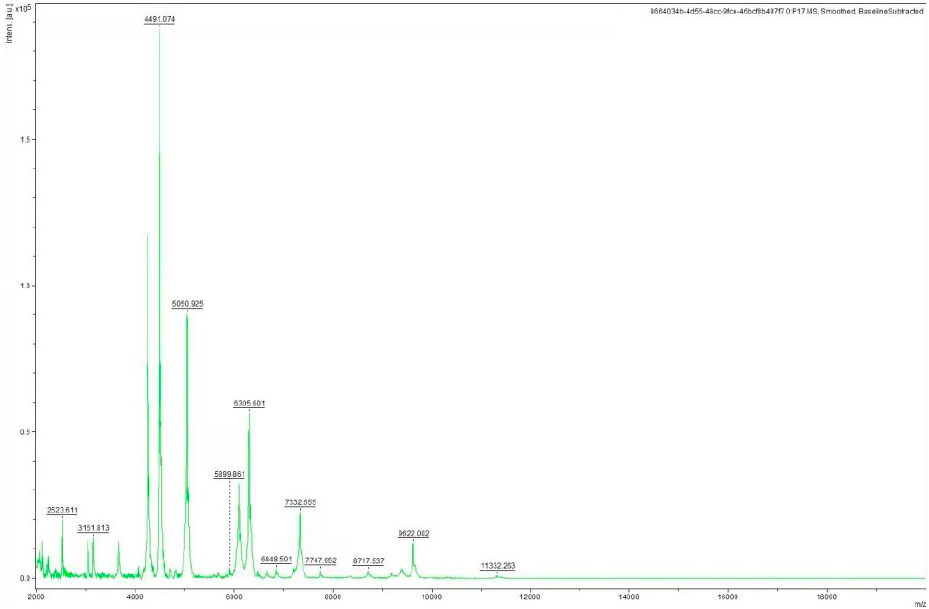
Figure 4. The characteristic mass spectrum of A.veronii isolate ZZ051 by MALDI-TOF-MS.